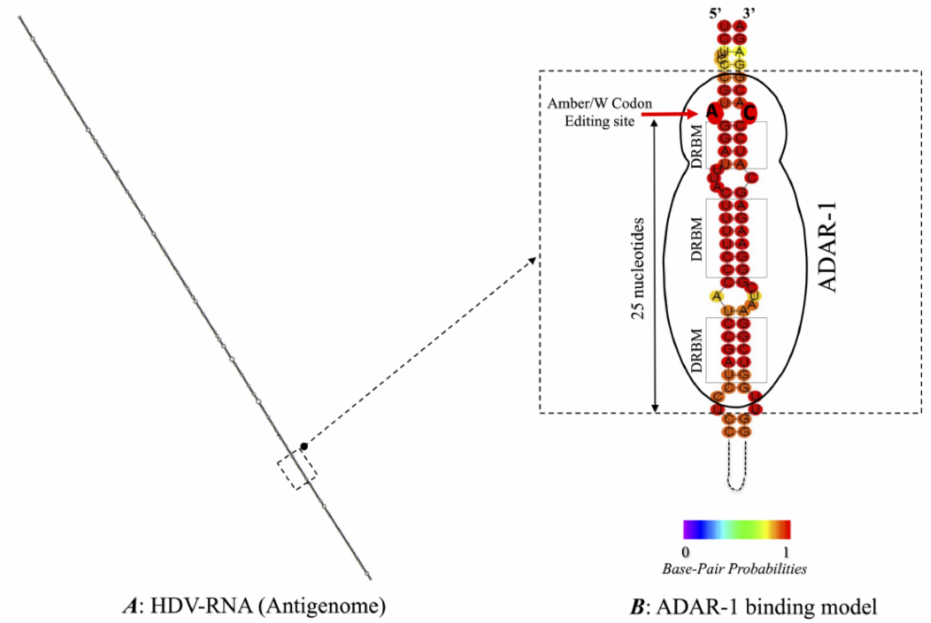
base-pairing for each DRBM.